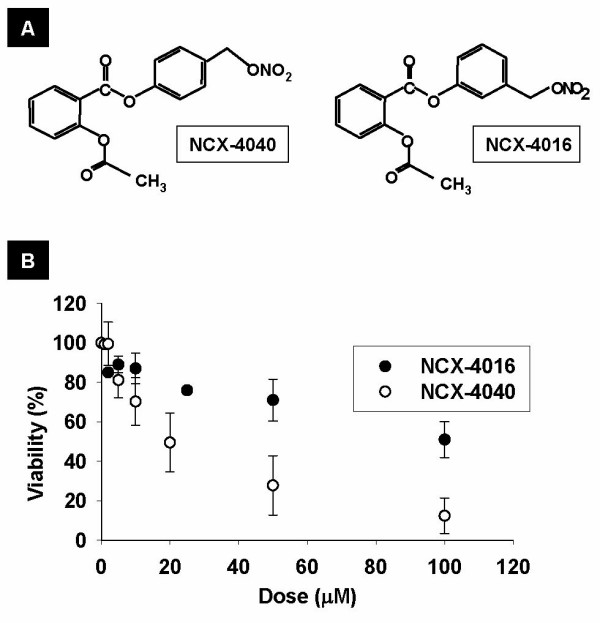
Comparision of the structure and effect of NCX-4040 and NCX-4016 on cell viability. (A) Molecular structure of NCX-4040 (acetyloxy)benzoic acid 4-(nitrooxymethyl)phenyl ester) and NCX-4016 (2-(acetyloxy)benzoic acid 3-(nitrooxymethyl)phenyl ester). The nitroaspirins consist of acetylsalicylate (aspirin) linked to a spacer moiety by an ester bond. An NO-releasing moiety (-ONO2) is attached to the spacer. (B) Effect of NCX-4040 and NCX-4016 (25 μM) on the viability of cisplatin-resistant human ovarian cancer cells (A2780 cDDP). The results show a dose-dependent cytotoxic effect, with NCX-4040 demonstrating a substantially higher effect compared to NCX-4016.